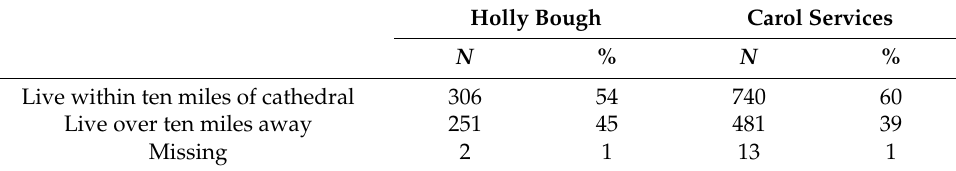
Table 5. Connection with Liverpool.